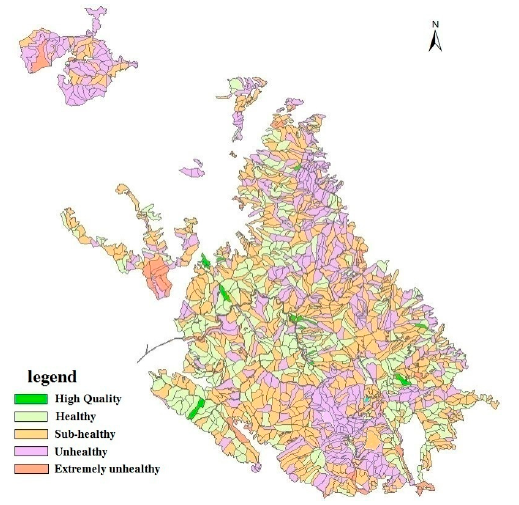
Figure 3. Health condition map of Mount Taishan forest ecosystem.